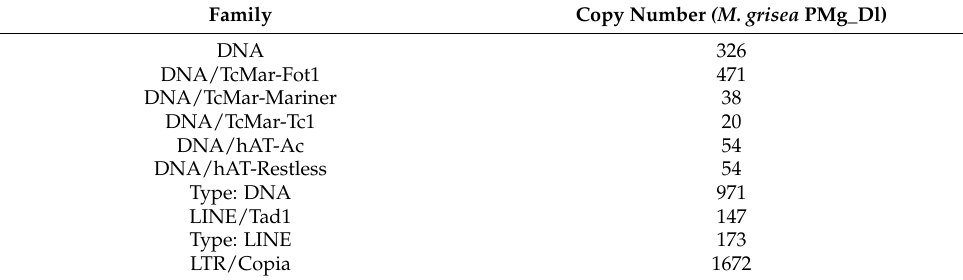
Table 2. Detected transposable elements in M. grisea PMg_Dl